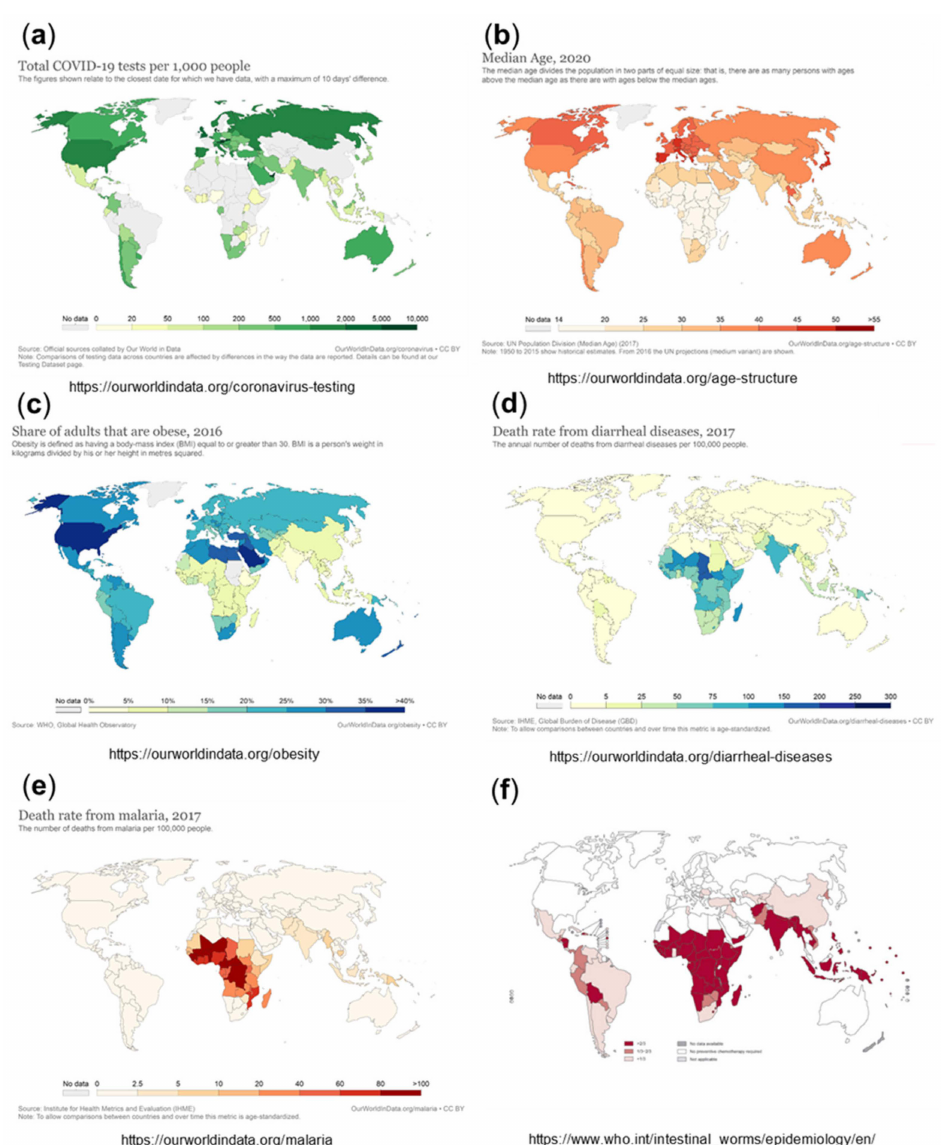
Figure 3. Total COVID-19 tests per 1000 people, from July 2021 ( a ), medium age, 2020 ( b ), share of adults who are obese, 2016 ( c ), death rate from diarrheal diseases ( d ), death rate from malaria, 2017 ( e ), and intestinal worms/epidemiology/soil transmitted helminthiases, 2011 ( f ). Sources ( a – e ): https://ourworldindata.org/ accessed on 5 July 2021; ( f ) https://www. who.int/intestinal_worms/epidemiology/en/ accessed on 5 July